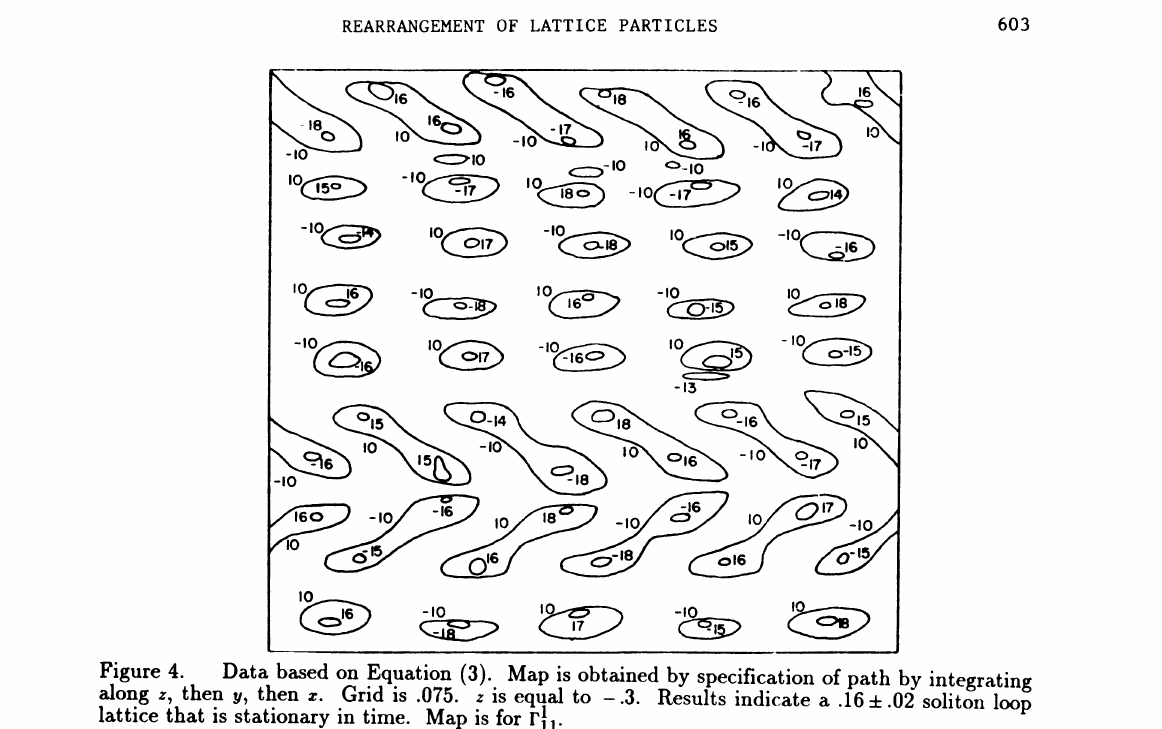
a .16 + .02 soliton loop